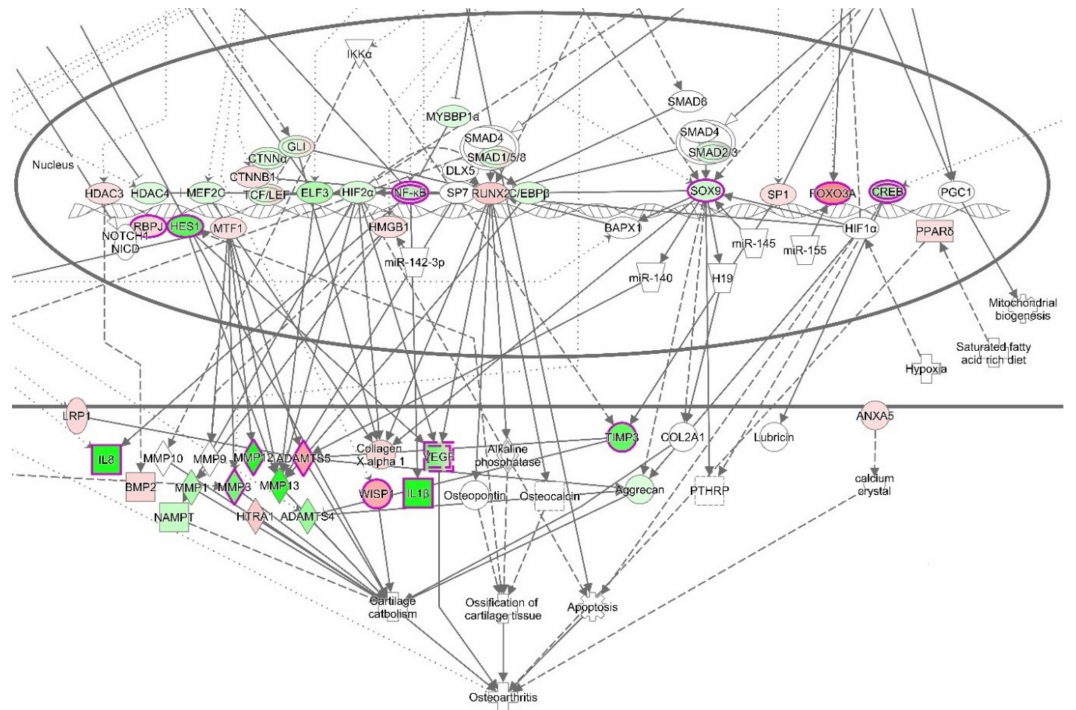
Figure 6. The canonical pathway “Osteoarthritis Signaling” for VA vs. Ctr treatment group. In this instance, the comparison of expected node activities and actual measurements suggest a reduced activity of this canonical pathway ( p -value: 5.5 × 10 − 12 z-score: − 0.707). Noteworthy is the downregulation of NF- κ B (expected activation) and inflammatory markers including IL-1 β . Red fillings = “activated”, green fillings = “inhibited”, purple highlights = passed cut-o ff s, no highlight = did not pass cut-o ff